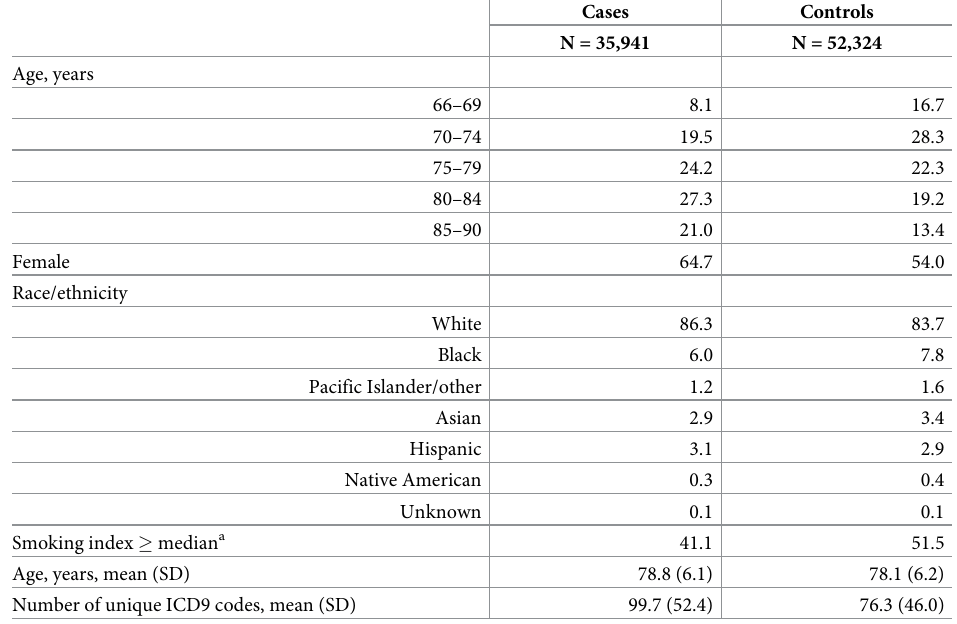
Table 1. Characteristics of Parkinson disease cases and controls with Medicare Part D coverage, U.S. Medicare 2009, %.